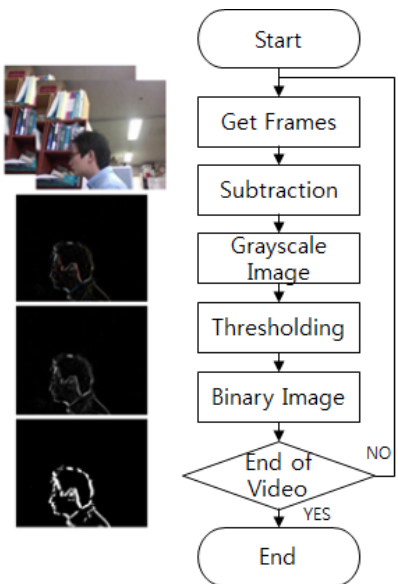
Figure 8. Flow chart of the object detection algorithm implemented for performance evaluation experiments.